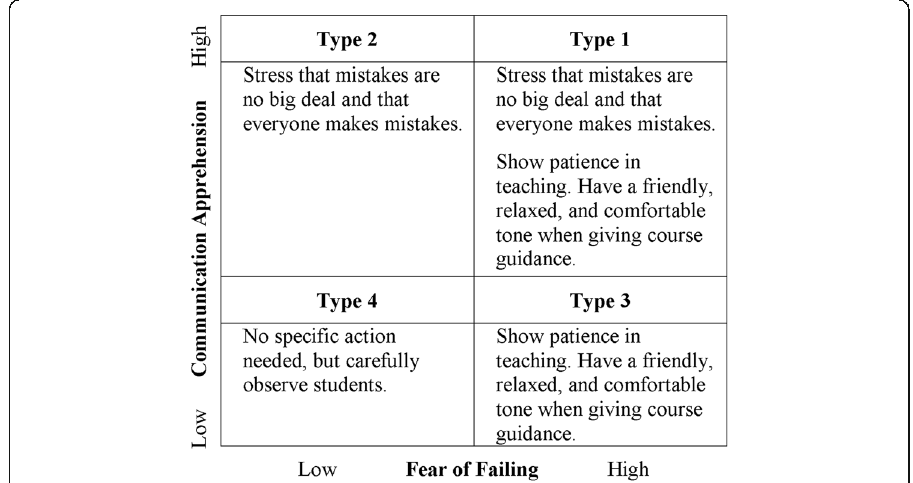
Fig. 1 Implications of the study: Adjustments that foreign language teachers can make based on student anxiety